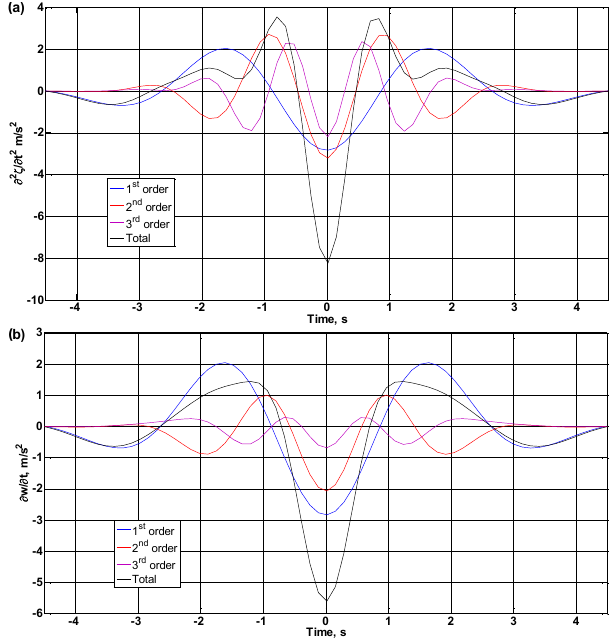
Fig. 3. (a) The “apparent” vertical acceleration ∂ 2 ζ/∂t 2 and (b) the Eulerian vertical acceleration ∂w/∂t for ε = 0 . 3, T 0 = 4 . 34s; λ 0 = 25 . 0m.